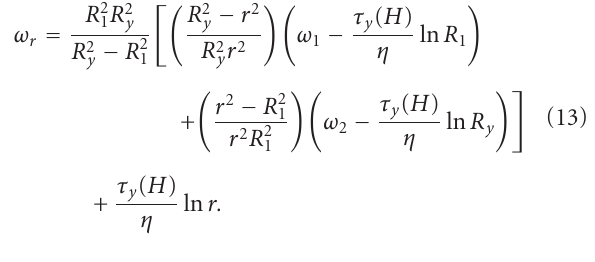
start and finish transformation temperatures of martensite and austenite,